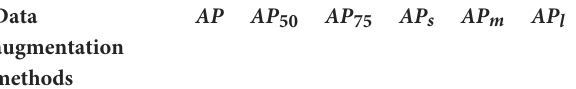
TABLE 1 Comparison of the data augmentation results. TABLE 2 Comparison of the ship detection